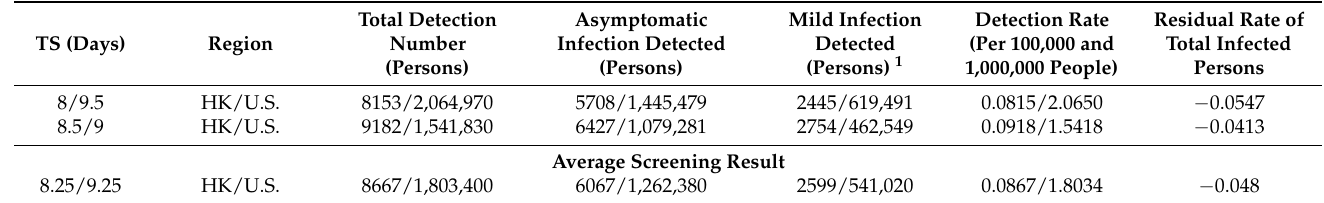
Table 8. Model Simulation Optimization Results Combined with Coding Screening